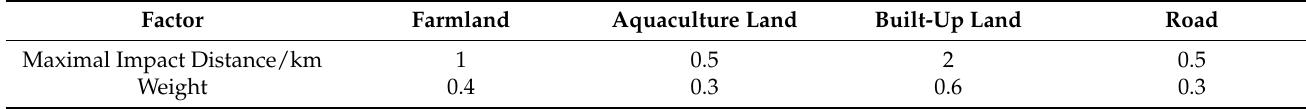
Table 1. Maximal impact distance and weight of the threat factors.